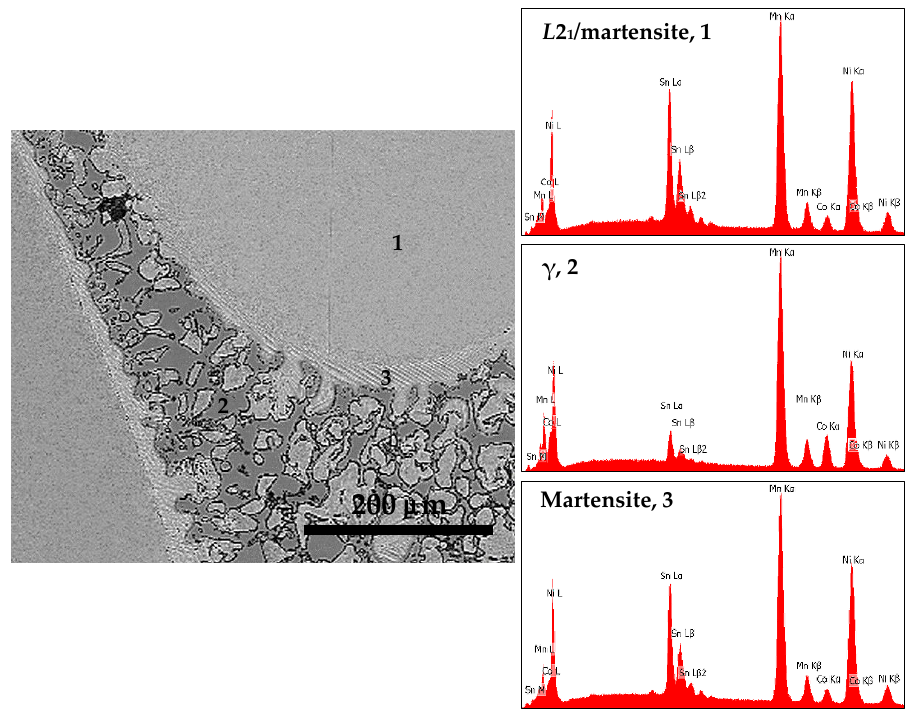
Figure 10. BSE micrograph and EDS spectra of different regions seen in S1050b4. Table 5. Composition of regions in the microstructures of the S1050a1, S1050a2, S1050b1, and S1050b2.